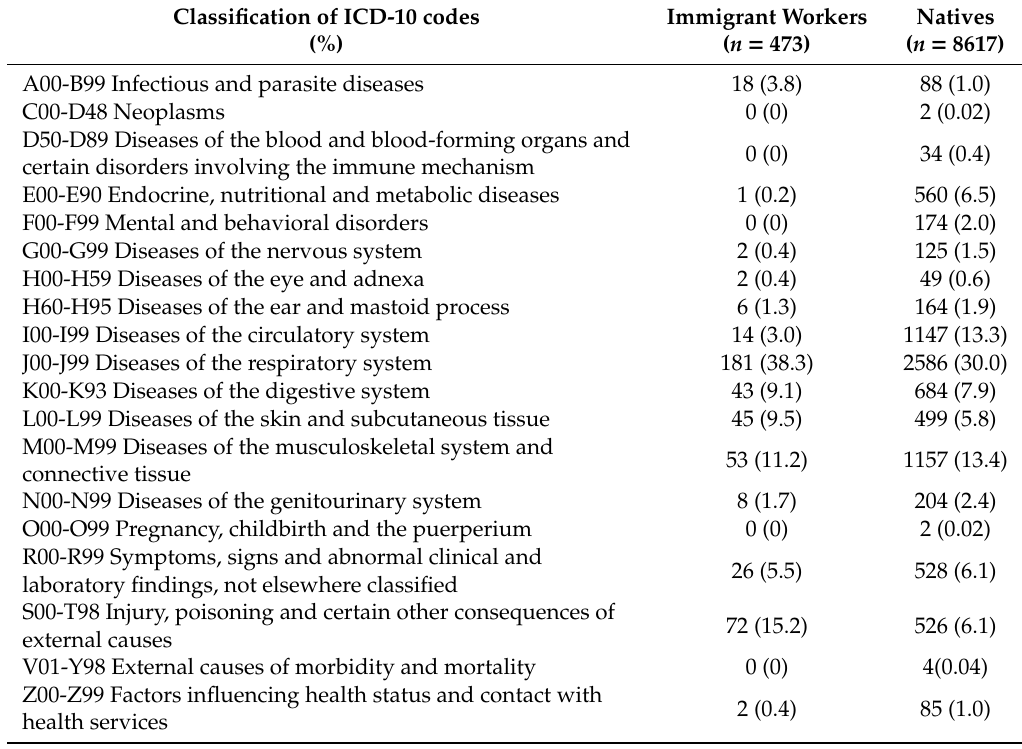
Table 3. List of major diagnosis of subjects’ visits *.